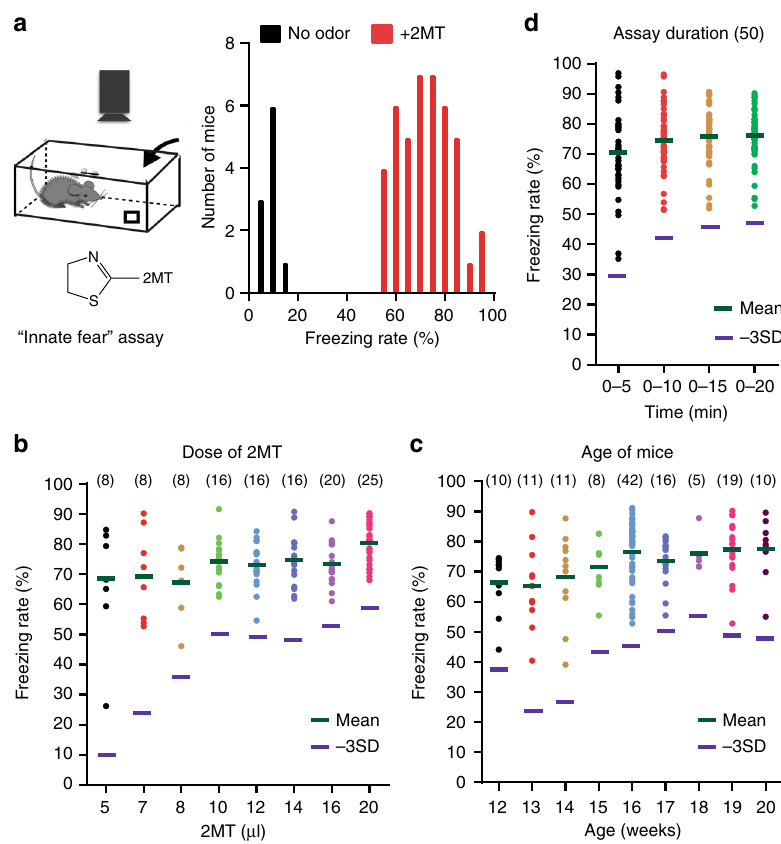
Fig. 1 Development of a highly robust innate fear assay. a A schematic of 2MT-evoked innate fear assay (left). A quantitative graph showing the distribution of freezing rates of C57BL/6J males with or without (20 µ l = 2.1 × 10 − 4 mole) 2MT exposure (right). b A graph showing the distribution of freezing rates (average 20 min) in C57BL/6J males (>15 week old) at different doses of 2MT exposure. c A graph showing the distribution of freezing rates (average 20 min) at different ages of C57BL/6J males exposed to 20 µ l of 2MT. d A graph showing the distribution of freezing rates for different assay duration using C57BL/6J males. − 3SD, 3 standard deviation (SD) below the normal mean of freezing rates upon 2MT exposure. The numbers